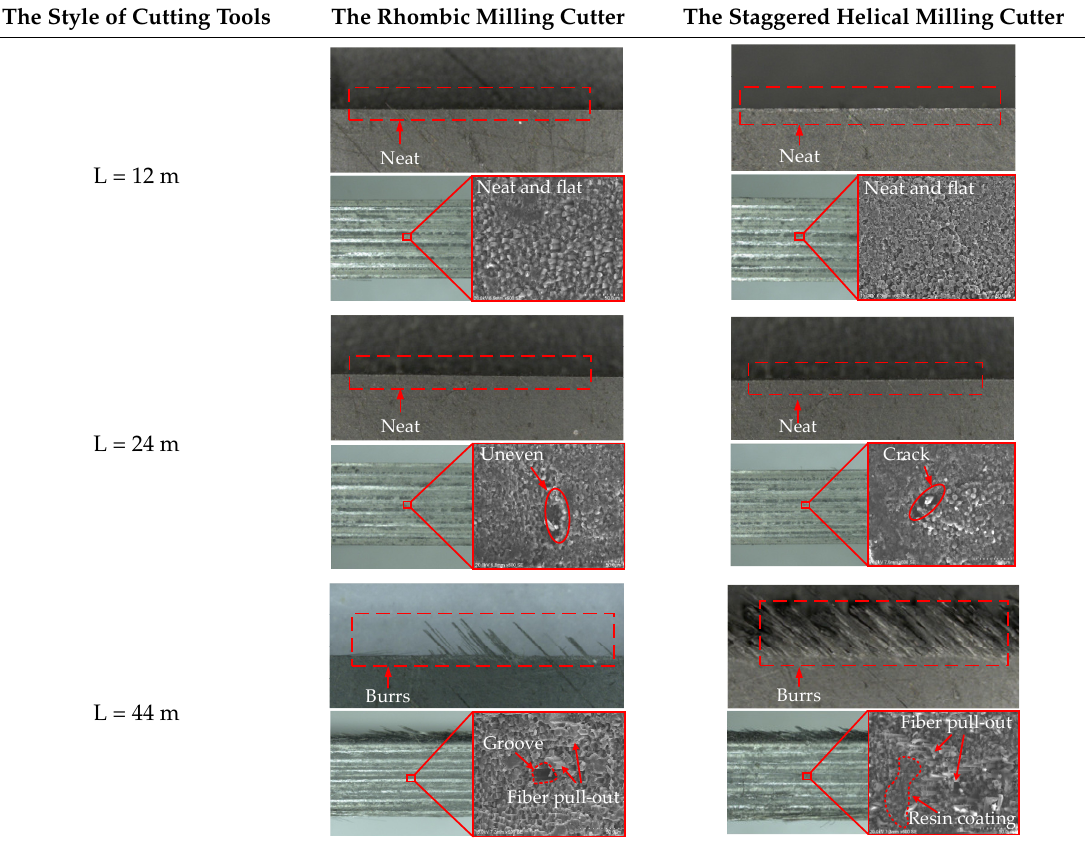
Table 1. The machined surface morphology in different milling lengths.